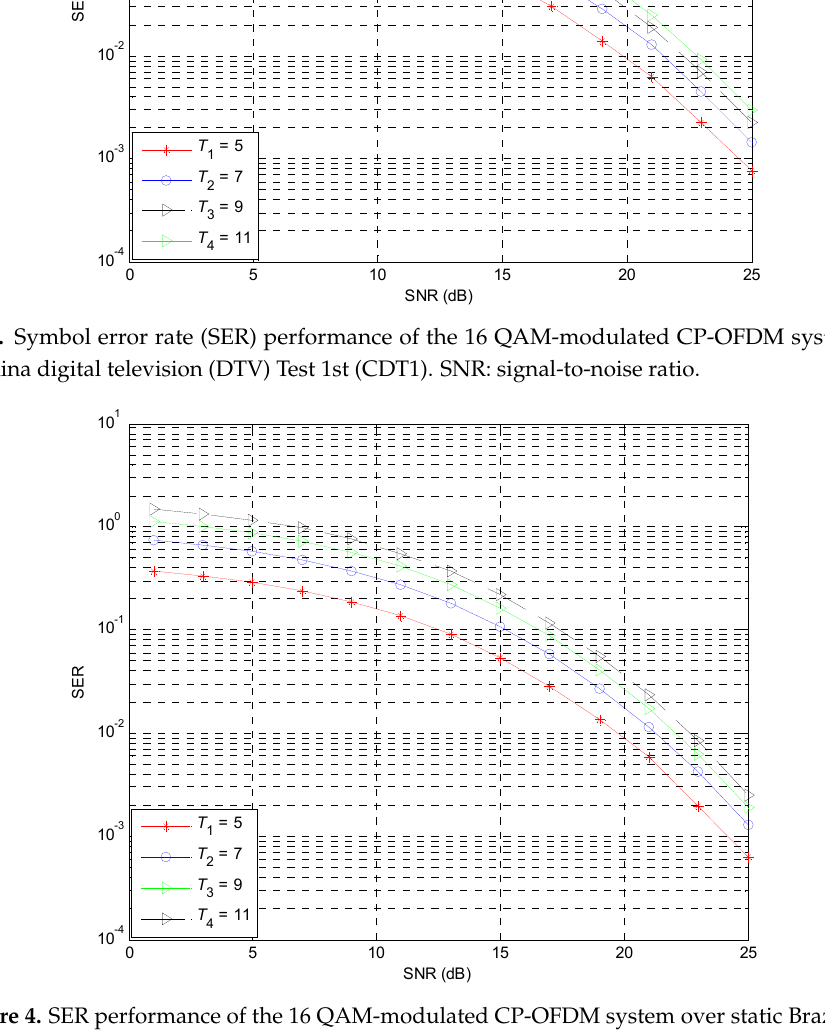
Figure 4. SER performance of the 16 QAM-modulated CP-OFDM system over static Brazil A.